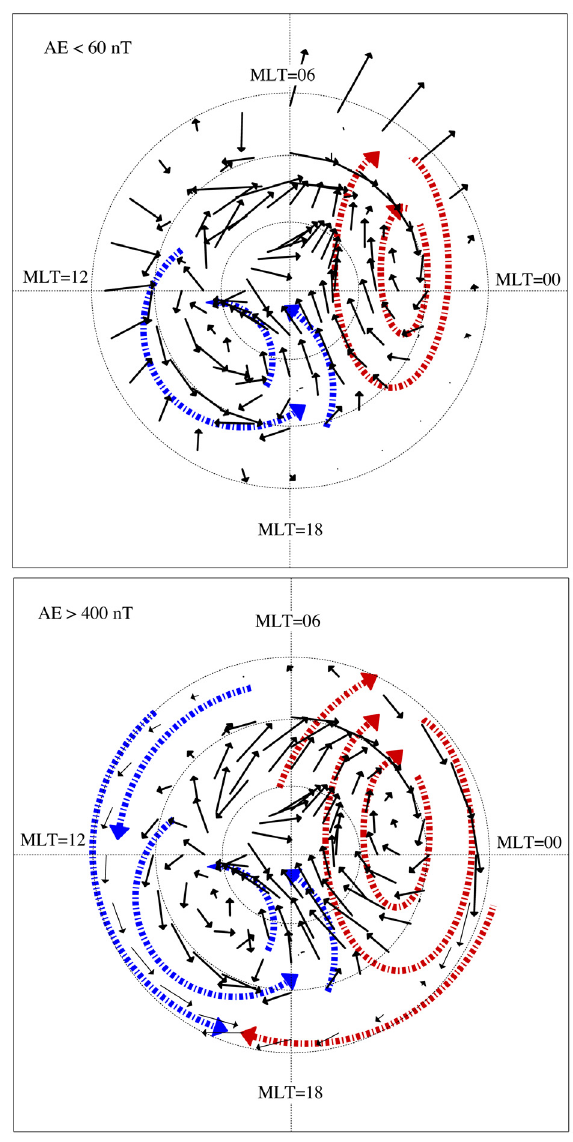
Figure 5. Polar diagrams of equivalent current vectors in the Northern Hemisphere. Coordinates are magnetic latitude from 60° to the North magnetic pole, and MLT. The equivalent current vec- tors are calculated by means of the first EOFs on the top panel in the case of a quiet period ( AE < 60 nT) and a disturbed one ( AE > 600 nT) on the bottom panel. The three circles mark, from the out- ermost one, the latitude of 60°, 70°, and 80°,